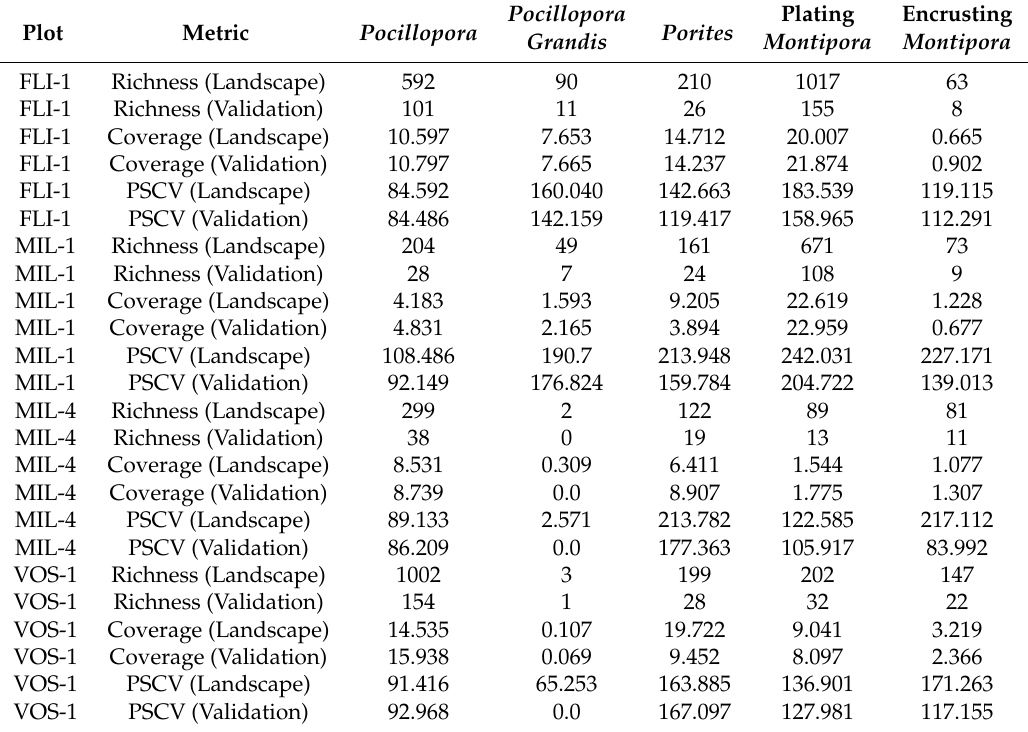
Table 1. Ecological metrics computed on the entire plot (Landscape) and the same metrics computed on the validation area found by our algorithm (Validation). Please note that the Richness of the validation region should be the 15% of the Landscape Richness because its area is the 15% of the area of the plot.